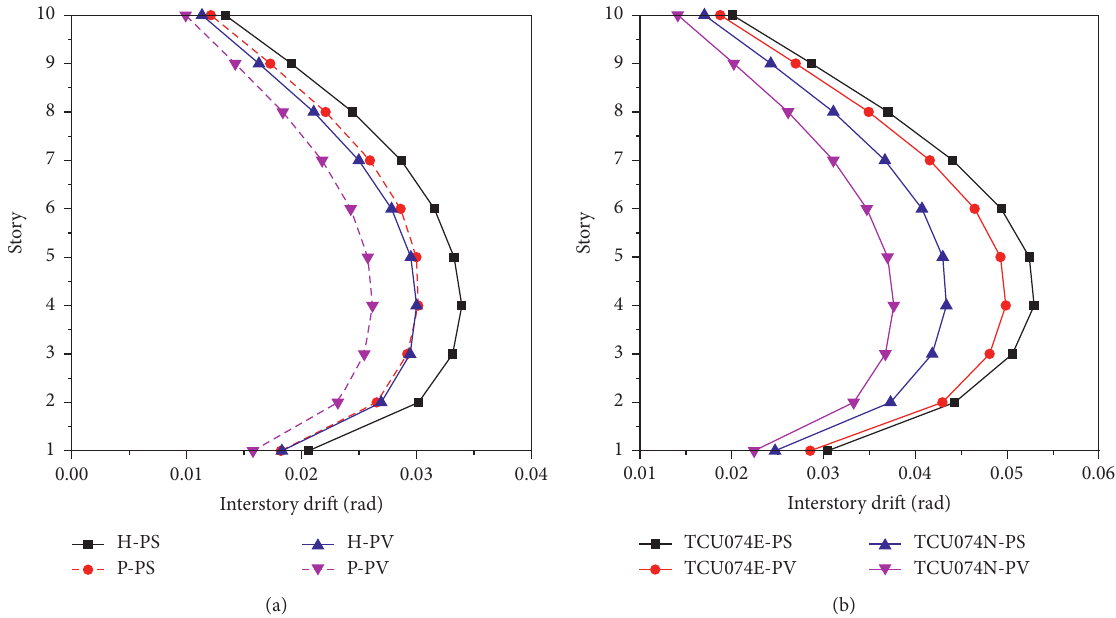
Figure 20: (a) The average peak interstory drift of the structure under the horizontal component and parallel component of near-fault ground motion; (b) the peak interstory drift of the structure under the ground motion of TCU074.